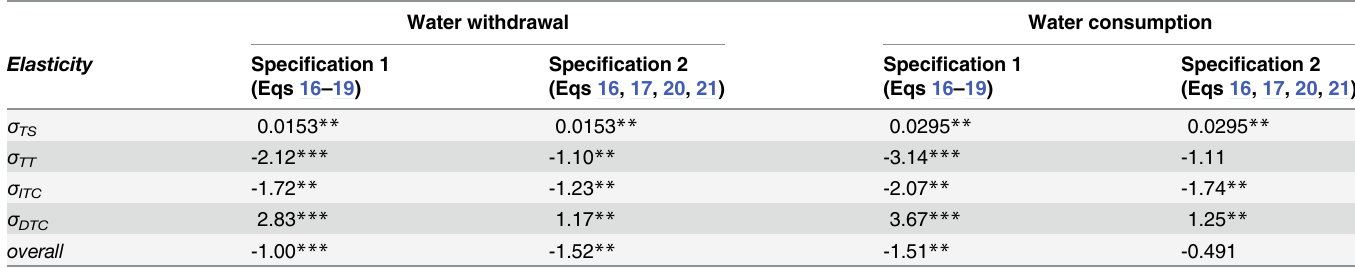
Table 6. Elasticity of trade